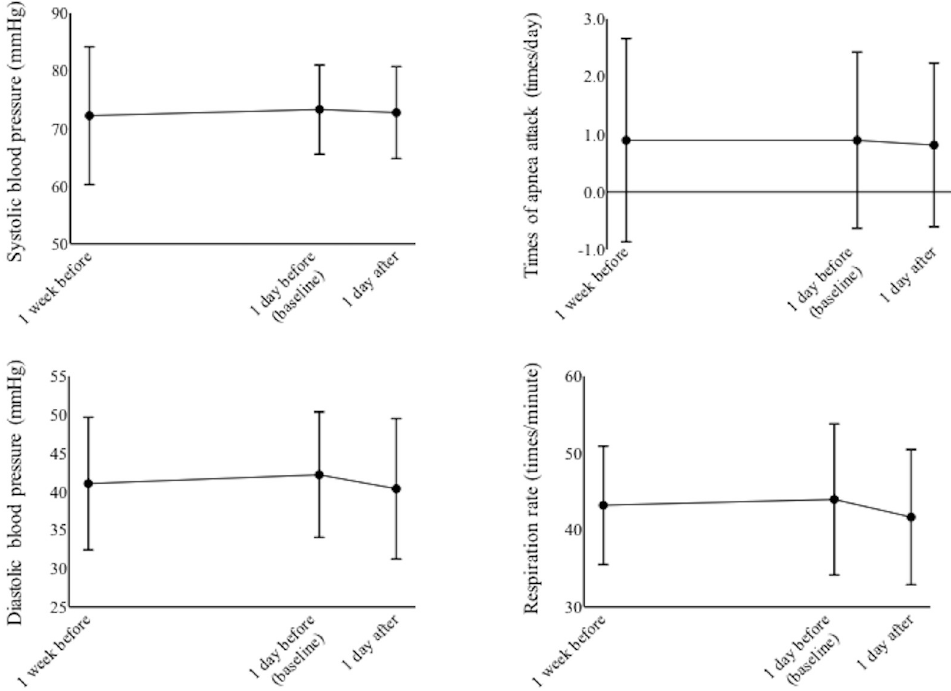
Fig 6. Systolic and diastolic blood pressure, number of periods of apnea and respiration rates from 1 week before examination to 1 day after